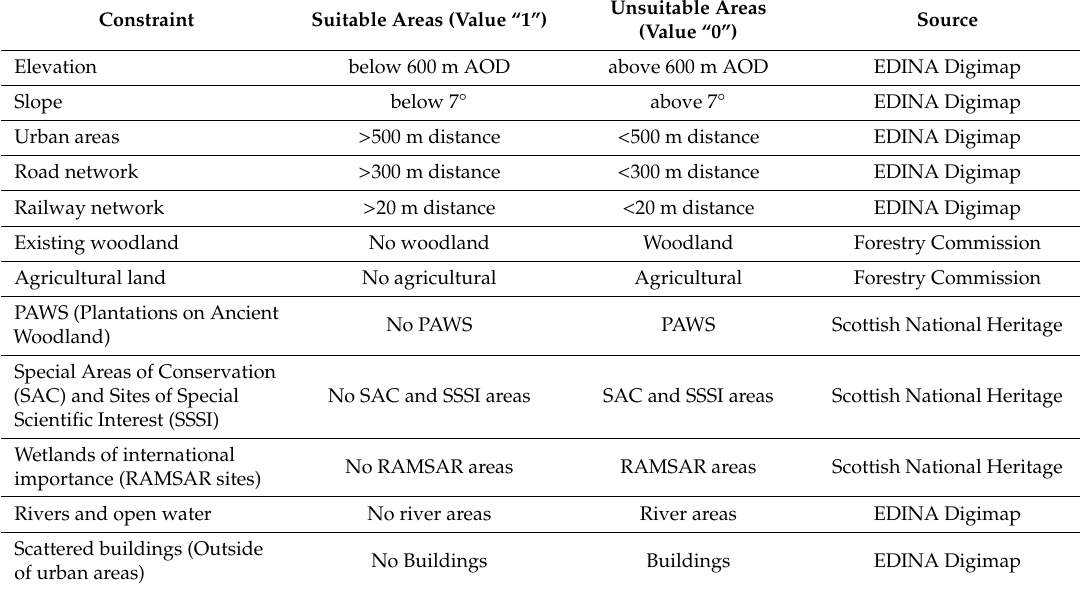
Table 1. The list of the 13 constraints and the sources used to support the